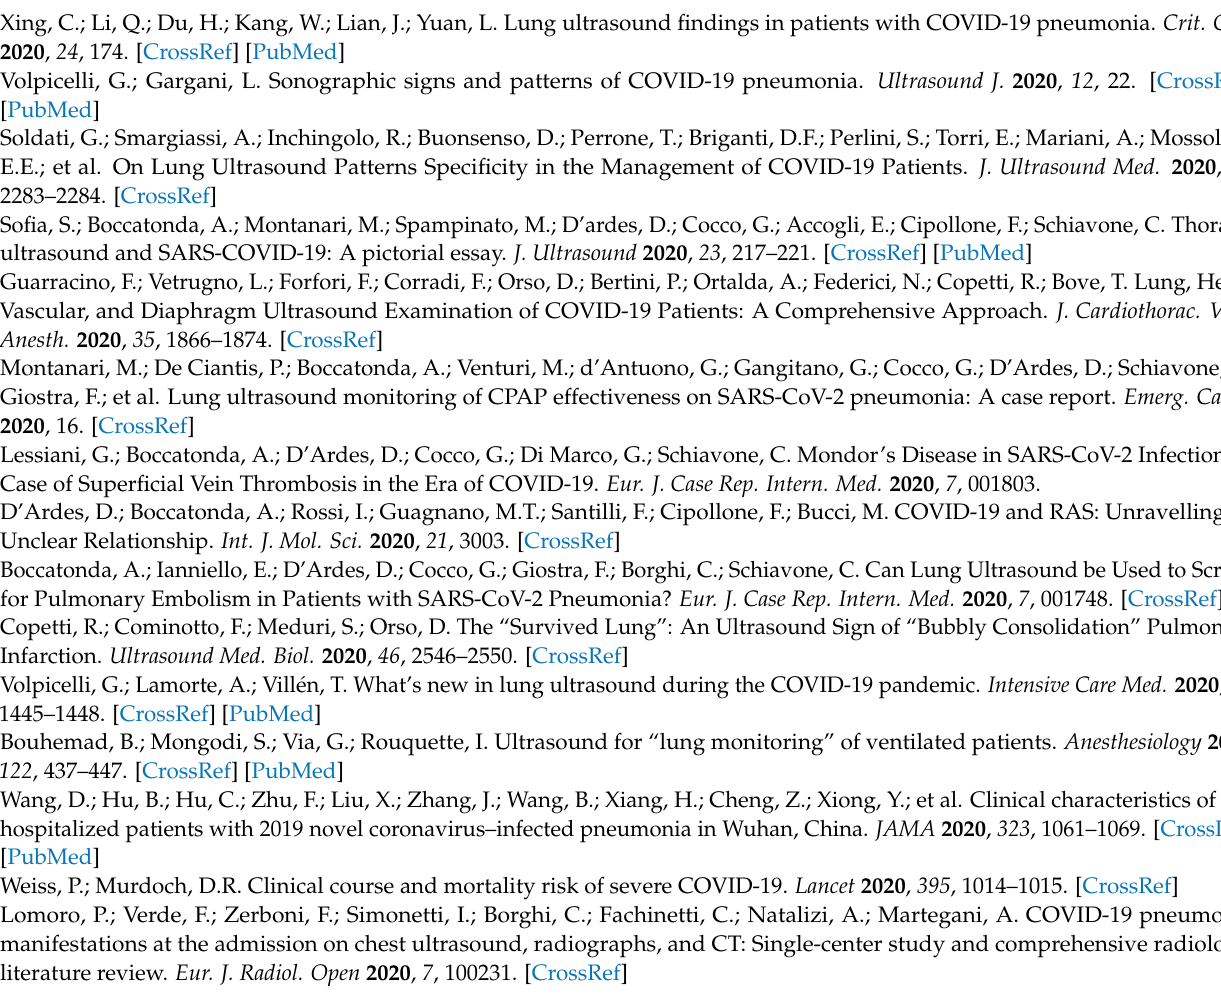
percentages. Table S3: Age and vital signs of patients on emergency department admission; SBP, systolic blood pressure; DBP, dy-astolic blood pressure; MAP, mean arterial pressure; CR, cardiac rate; RR, respiratory rate. Con-tinuous variables are expressed as mean ± standard deviation. Table S4: Data derived by ROC analysis for 30-days mortality in COVID-19 patients; AUC, area under the curve; IC, confidence